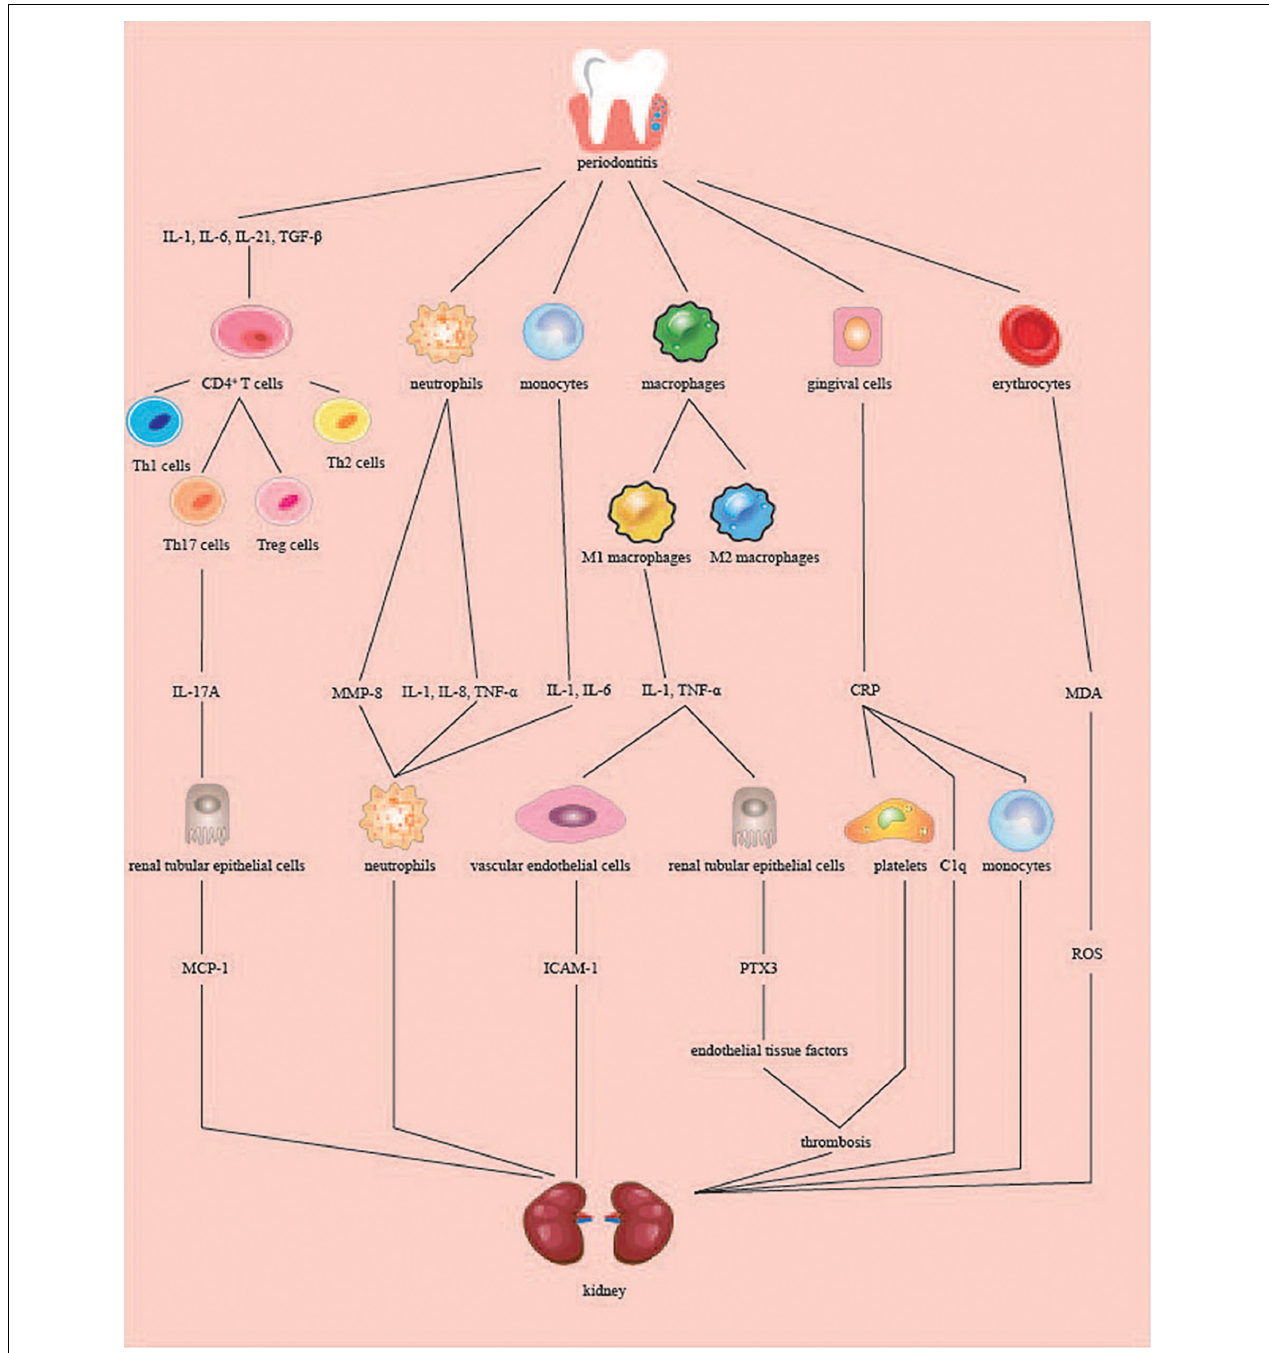
FIGURE 2 | Role of periodontitis in kidney inflammation. When periodontitis occurs, periodontal tissues produce inflammatory cytokines, which are translocated to the kidneys through the blood circulation. CD4 + T cells are today classified into four major subsets: Th1, Th2, Th17, and Treg cells. IL-1, IL-6, IL-21, TGF- β induced CD4(+) T cells to differentiate into Th17A cells, and IL-17A produced stimulated renal tubular epithelial cells to produce MCP-1. The neutrophils and monocytes induced by periodontitis produced MMP-8, IL-1, IL-6, IL-8, and TNF- α , among which MMP-8, IL-8, and IL-6 acted on the neutrophils at the site of inflammation and produced an inflammatory response. IL-1 and TNF- α stimulated by macrophages can promote the production of ICAM-1 by vascular endothelial cells on the kidney or promote the production of PTX3 by renal tubular epithelial cells. PTX3 increases endothelial tissue factors involved in renal thrombosis. CRP produced by gingival cells stimulates platelet aggregation to form thrombus and combine C1q and factors of complement. Periodontitis raises the level of MDA in red blood cells, plasma and local tissues, which leads to the upregulation of ROS. Th, T-helper; Treg cells, regulatory T cells; MCP-1, monocyte chemotactic protein-1; MMP-8, matrix metalloproteinase 8; TNF- α , tumor necrosis factor alpha; ICAM-1, intercellular adhesion molecule-1; PTX3, pentraxins 3; CRP, C-reactive protein; MDA, malondialdehyde; ROS, reactive oxygen species.